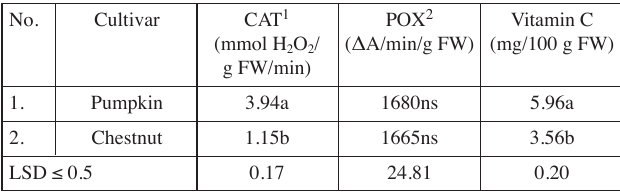
Tab. 2: Enzymatic activity and vitamin C content of sweet potato